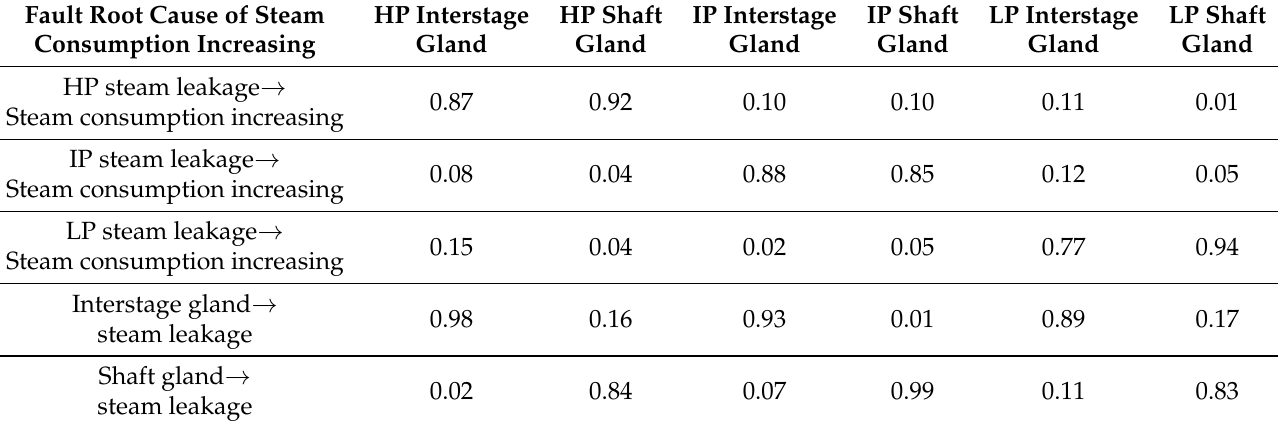
Table 4. Average scores of the transition between fault